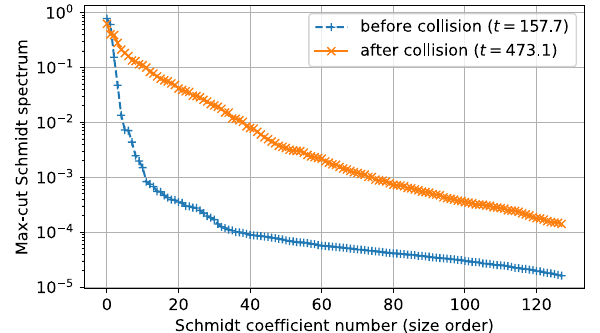
FIG. 21. Schmidt spectra for the maximum-entropy cut before and after the first collision in simulation (ii) of the main text. The bond dimension is